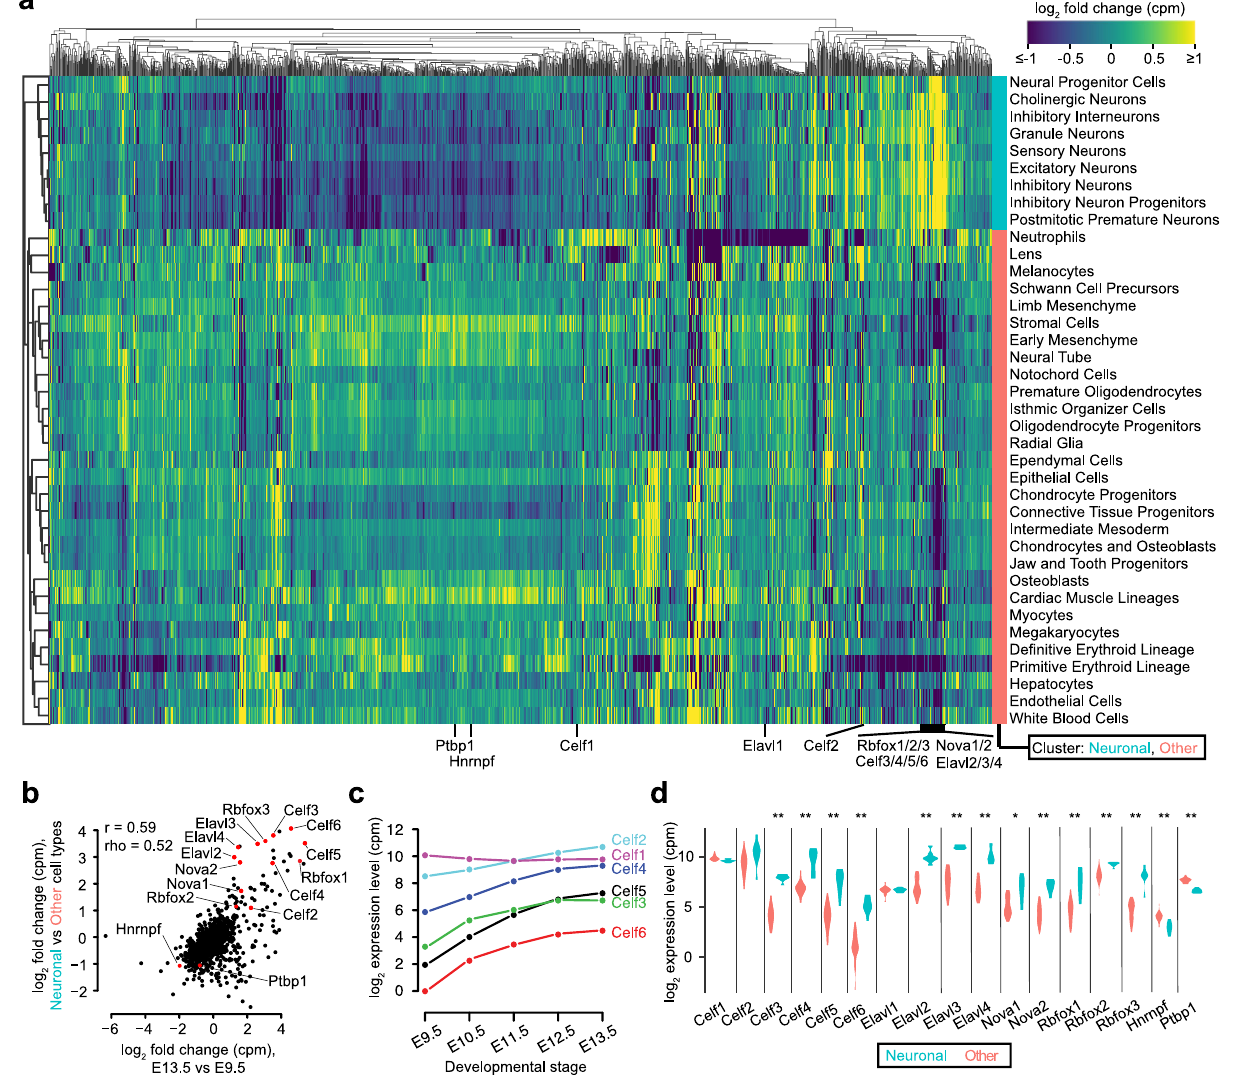
Fig. 6 Evaluation of putative RNA-binding protein regulators of alternative polyadenylation. a Heatmap of relative gene expression levels, quanti fi ed as log 2 (counts per million), for a set of 1576 RBPs across cell types derived from 38 t-SNE clusters. Heatmap is column-centered and clustered in both rows and columns by Pearson correlation as a distance metric. b Relationship of changes in RBP expression between E13.5 vs. E9.5 relative to neuronal vs. other cell types. Also listed are the Pearson ( r ) and Spearman (rho) correlations. c Expression levels of Celf1-6 across the fi ve developmental stages. Expression is quanti fi ed in counts per million (cpm) and shown on a log 2 scale. All genes displayed signi fi cant differential expression across stages, with a Bonferroni- corrected P < 0.001 as assessed by the χ 2 test for homogeneity, using PAS-mapping read counts associated with the RBP of interest versus all other RBPs. d Expression levels of genes highlighted in ( b ) in neuronal cell types relative to other cell types. Signi fi cant differences between the two groups were assessed by a two-sided Wilcoxon rank-sum test, with P values adjusted for multiple hypothesis testing with a Bonferroni correction (* P < 0.01, ** P < 10 − 4 ). Exact P values for panels ( c , d ) are provided in Supplementary Table